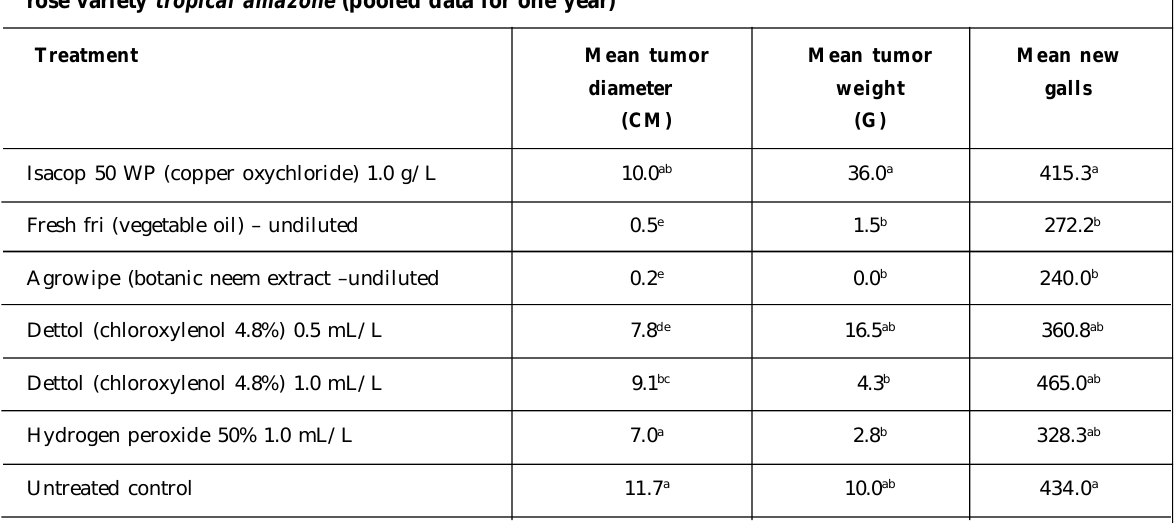
Table 3: Efficacy of Isacop 50 WP (copper oxychloride), fresh fri (vegetable oil), agrowipe (botanic neem extract), dettol (chloroxylenol 4.8%), hydrogen peroxide 50% and untreated control on crown gall